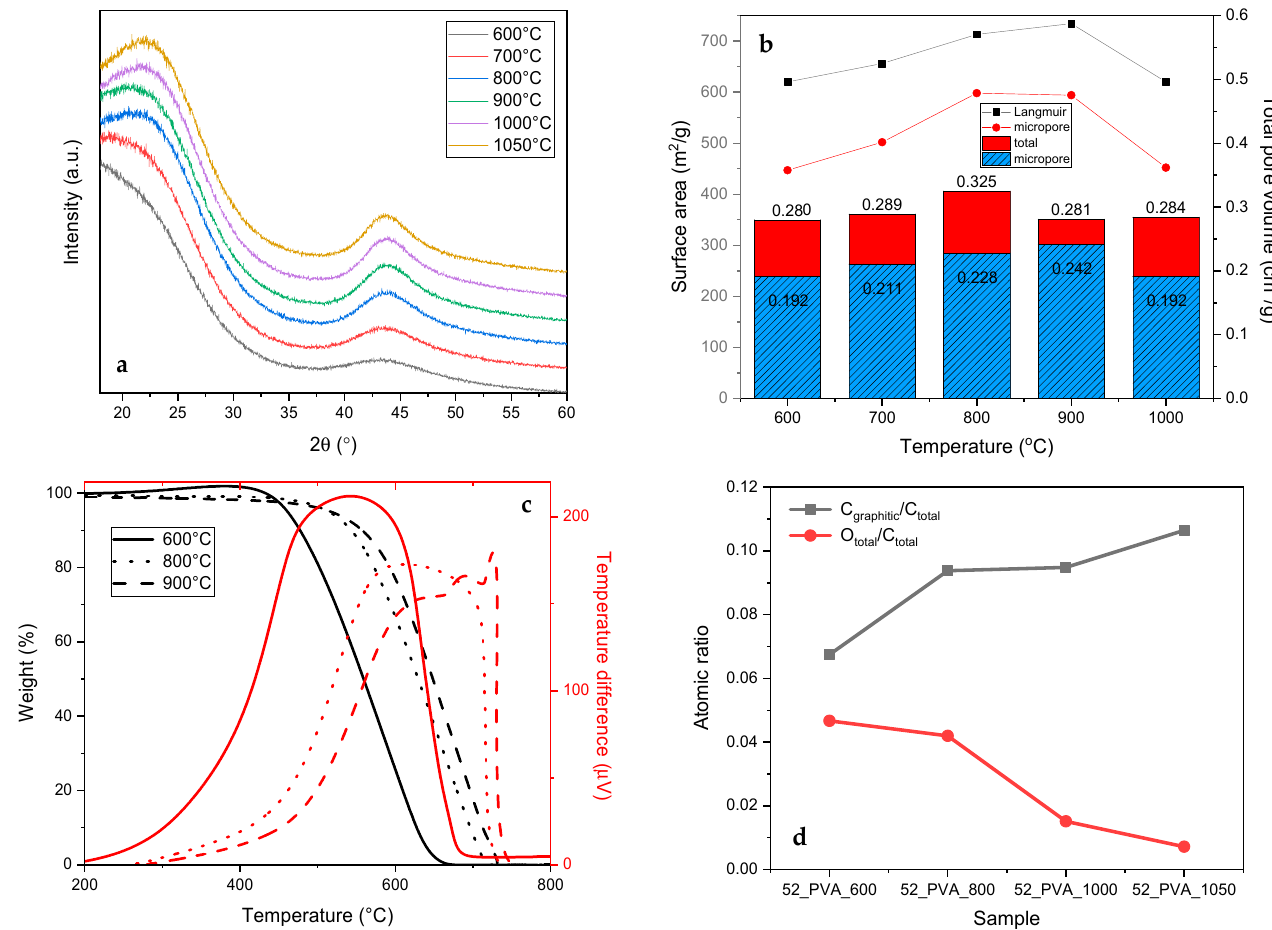
Figure 5. Changes in properties of the 52_PVA resin-derived carbon materials induced by raising the carbonization temperature: ( a ) X-ray diffraction patterns, ( b ) textural parameters, ( c ) TG–DTA curves, and ( d ) surface composition determined by XPS.